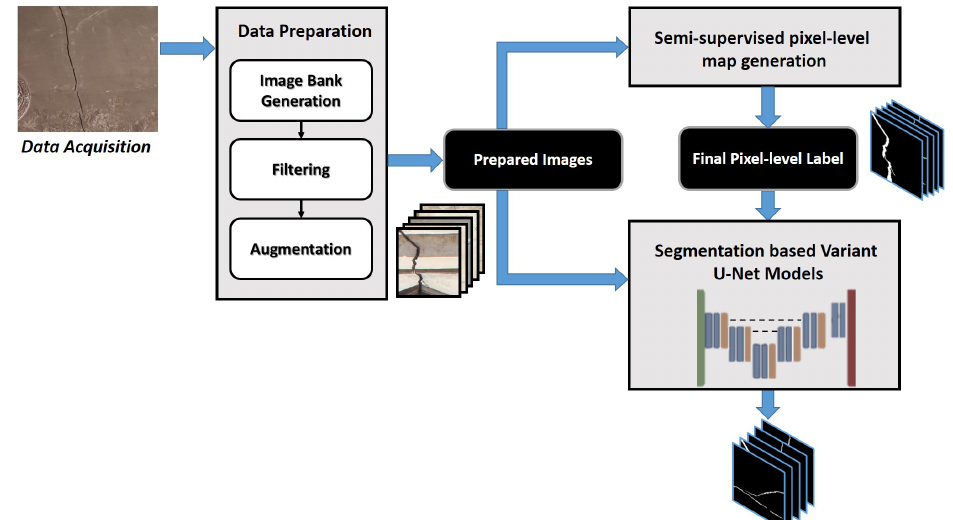
Figure 2. Structure of the proposed deep crack segmentation